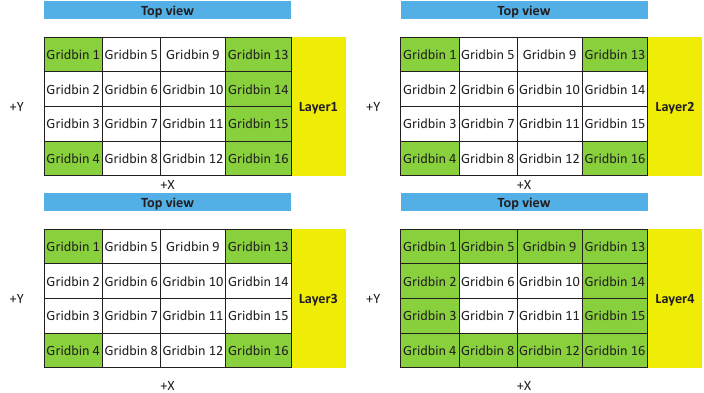
Figure 4. Layer-wise representation of the grid bins in the Cartesian system.